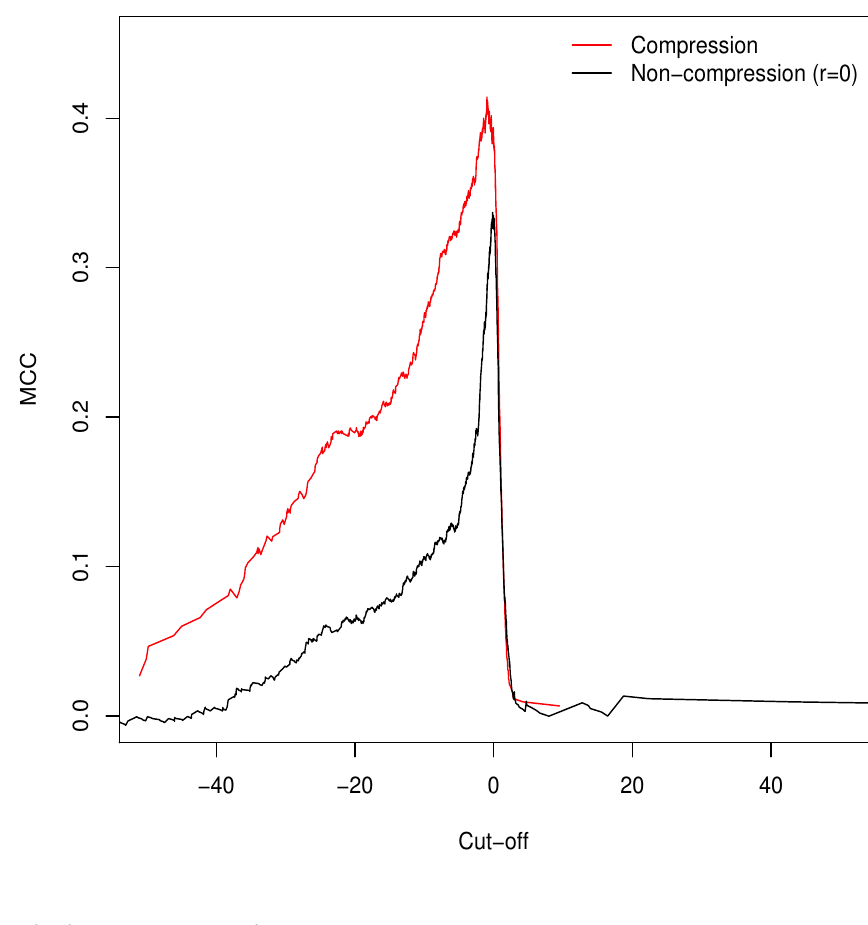
Figure 2. Matthews Correlation Coefficient for all possible cut-off values demonstrates that GM = C is, in keeping with theory, the empirical optimum. Adjustment of GV with compression ratios results in improved performance across the full range of